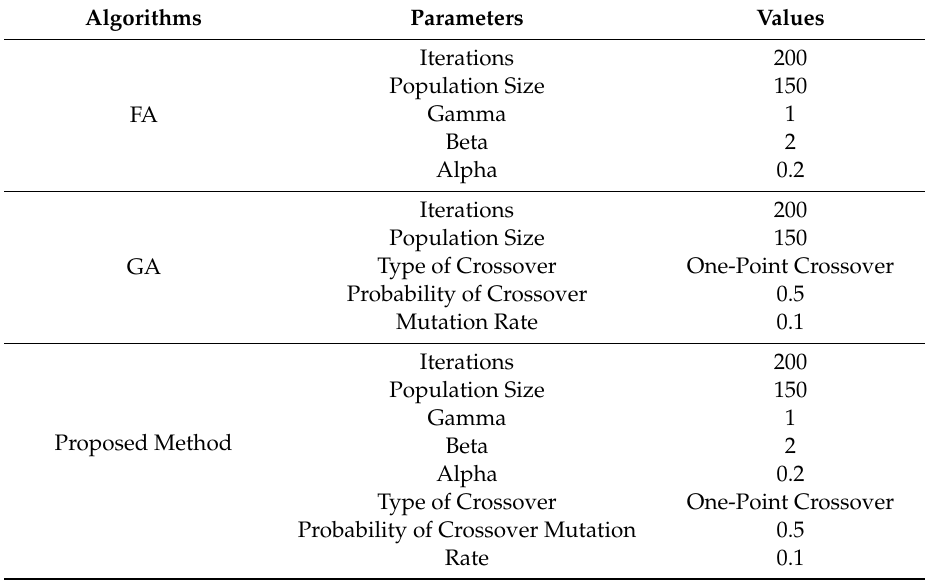
Table 2. Model parameters. FA: firefly algorithm and GA: genetic algorithm.